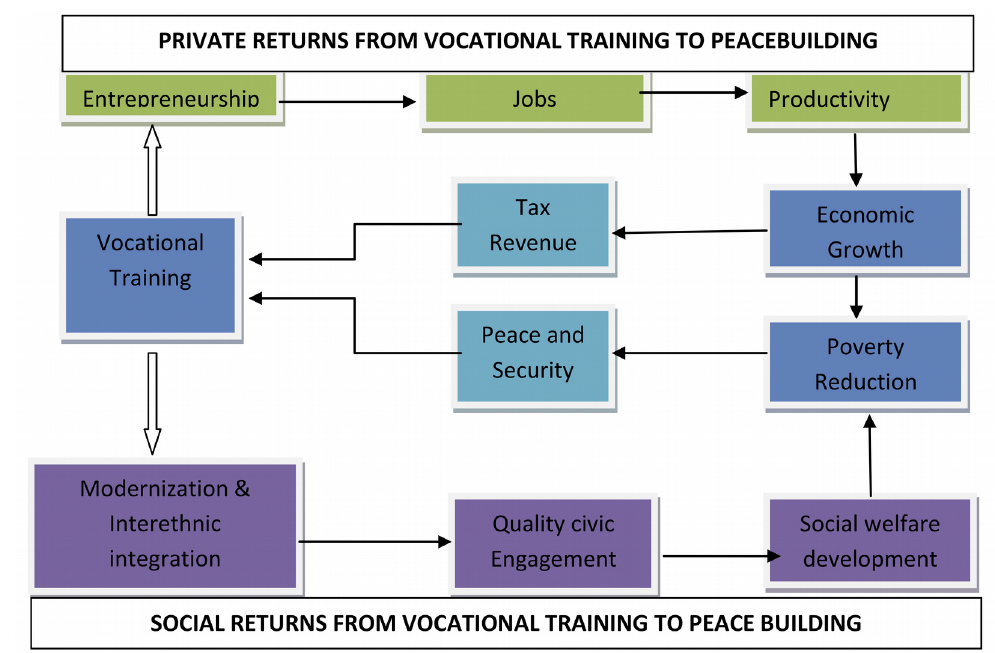
Figure 5. The links between vocational training and peace